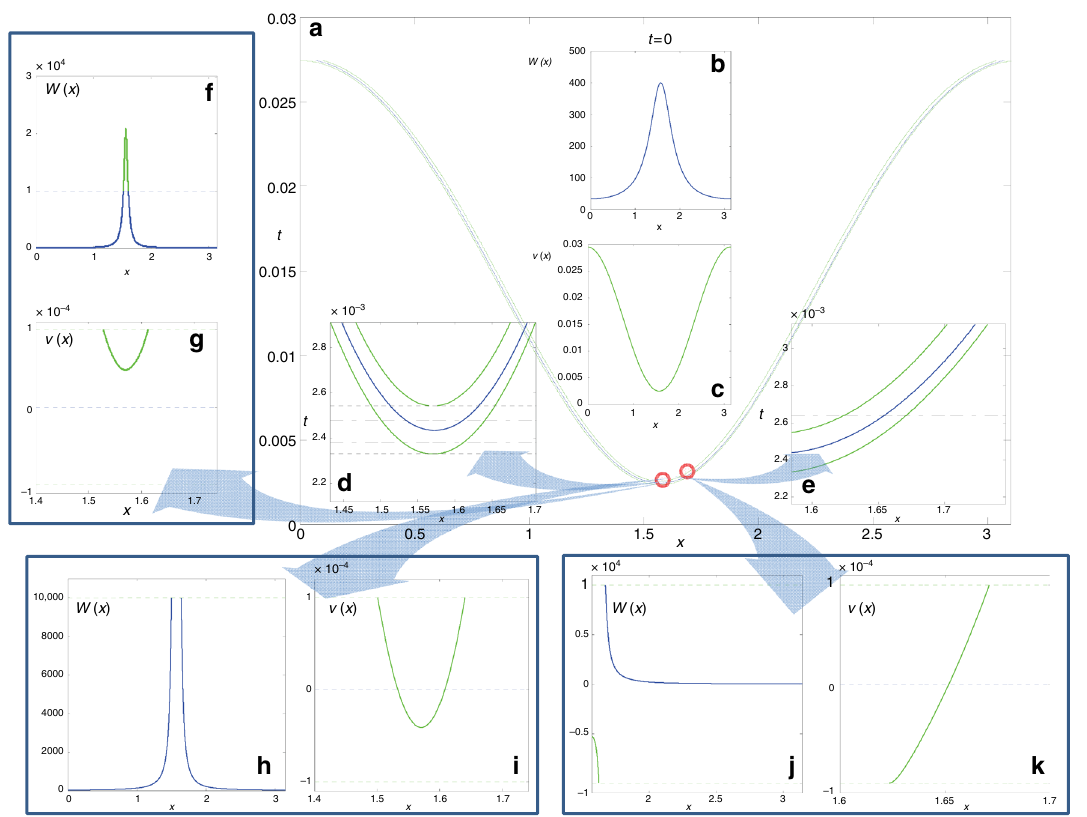
Fig. 3 Schematic of the computation for the PDE paradigm. The main background a shows the locus (in blue) of the points in space-time where w becomes in fi nite. The two accompanying (green) solid curves de fi ne the bands within which we solve the good equation for ν = 1/ w . The central insets in a , i.e., b , c show the initial bad equation pro fi le w ( x ) b and the good pro fi le ν ( x ) c at t = 0. Insets d , e zoom at speci fi c points. Insets f , g take place after we have crossed our selected high level (here 10 4 ) for w de fi ning the buffer region boundary, but have not yet crossed in fi nity; both the bad ( w ) f and good ( ν ) g solutions are shown. Insets h , i take place after w crossed in fi nity, but has not (in absolute values) receded below the high level de fi ning the buffer regions. Again both the bad ( w ) h and the good ( ν ) i solutions are shown. Insets j , k show the solution of the good equation ν k (inside the band) and of the bad equation w j (outside the band) after the singularity point has started propagating to the right (and